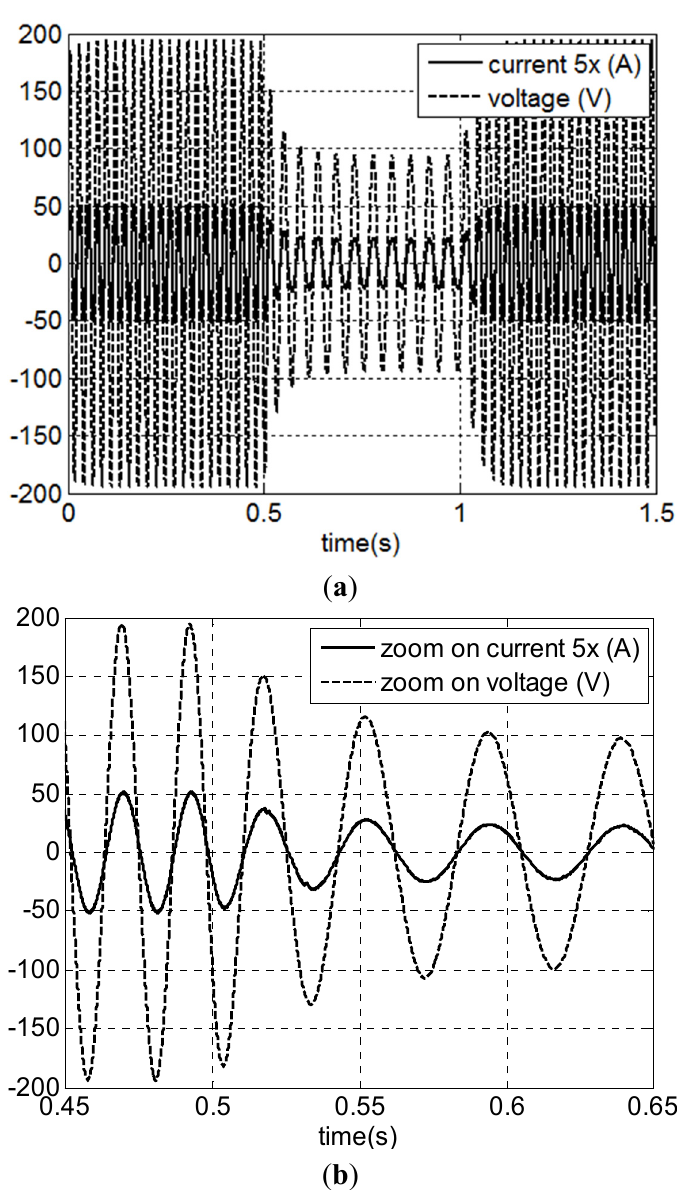
Figure 25. Simulation with P&O MPPT technique and variable wind speed: ( a ) PMSG voltage and current; ( b ) zoom of ( a